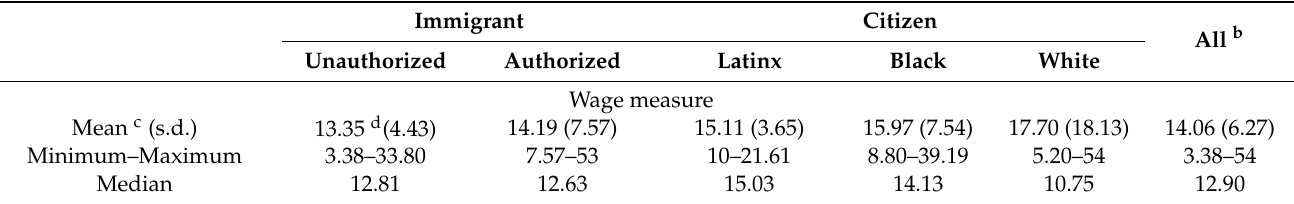
Table 3. Hourly income a (adjusted to 2021 USD).